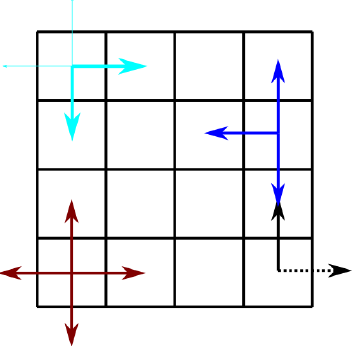
Figure 2. Problems that arise at the borders of the grid. When us- ing the definition of the derivative, at the one side, the derivative over the border cannot be included directly (black arrows). Possible solutions to the border problem for symmetric derivatives are also shown in the figure (cyan, blue, brown